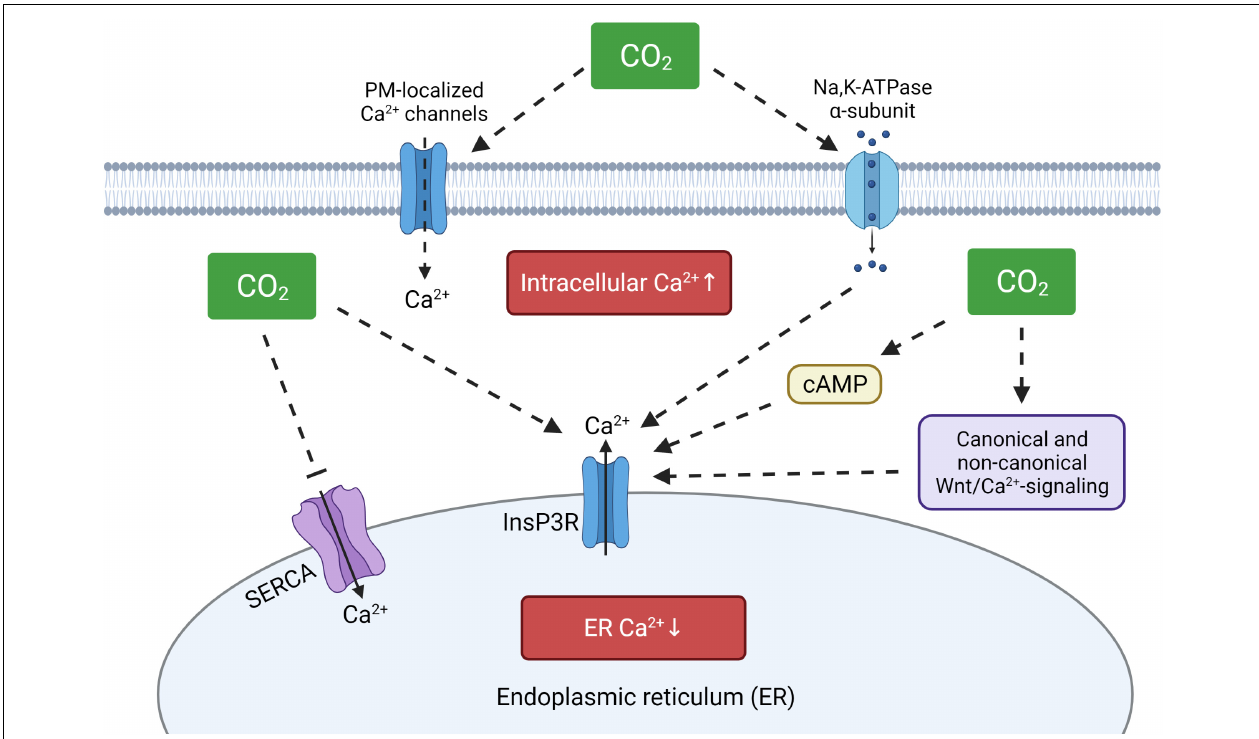
FIGURE 2 | Proposed model of hypercapnia-induced intracellular Ca 2 + disturbances. Elevated CO 2 levels may increase intracellular calcium concentrations by activation of plasma membrane-localized Ca 2 + channels, by direct or indirect stimulation of ER-resident InsP3R and by modulating SERCA activity. ER, endoplasmic reticulum; InsP3R, ER membrane-localized inositol trisphosphate receptor; SERCA, sarco/endoplasmic reticulum Ca 2 + -ATPase, cAMP, cyclic adenosine monophosphate. Created with